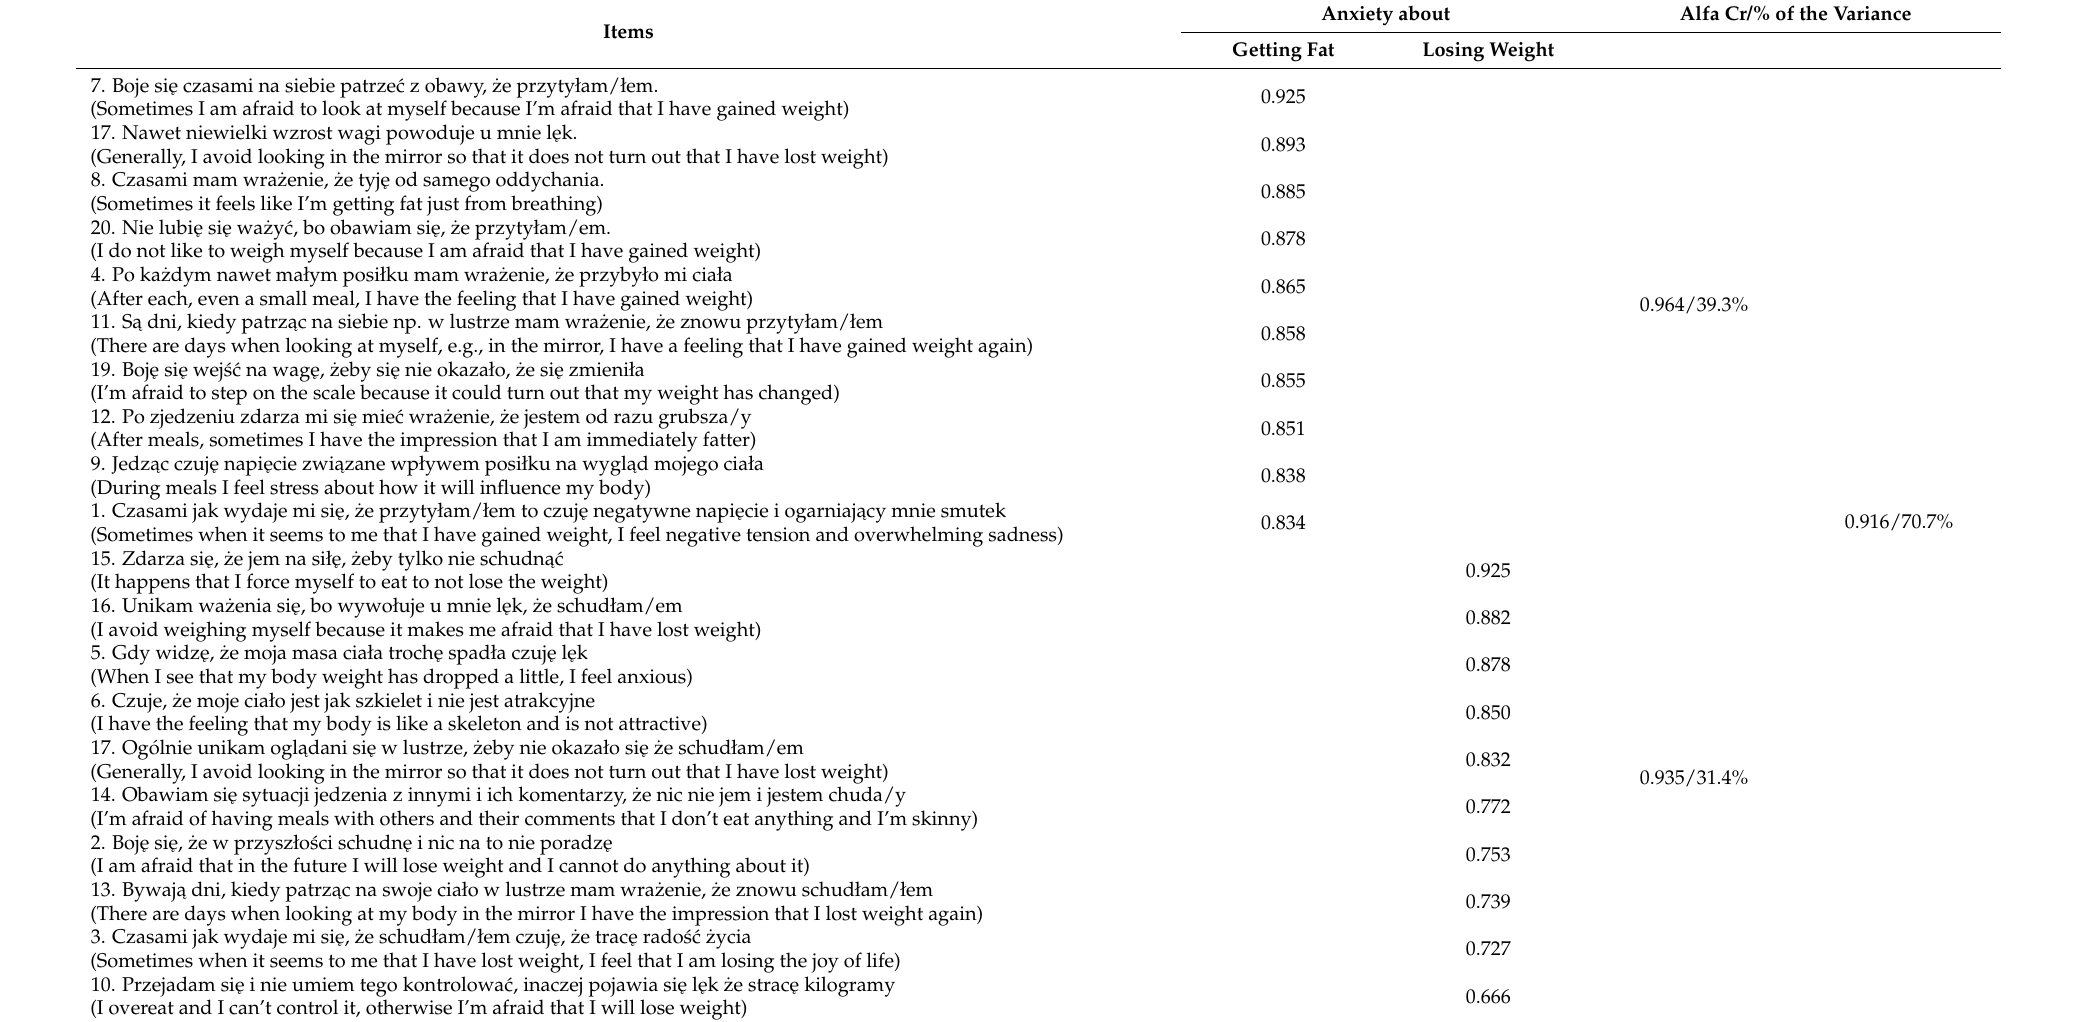
Table 1. Exploratory Factor Analysis of